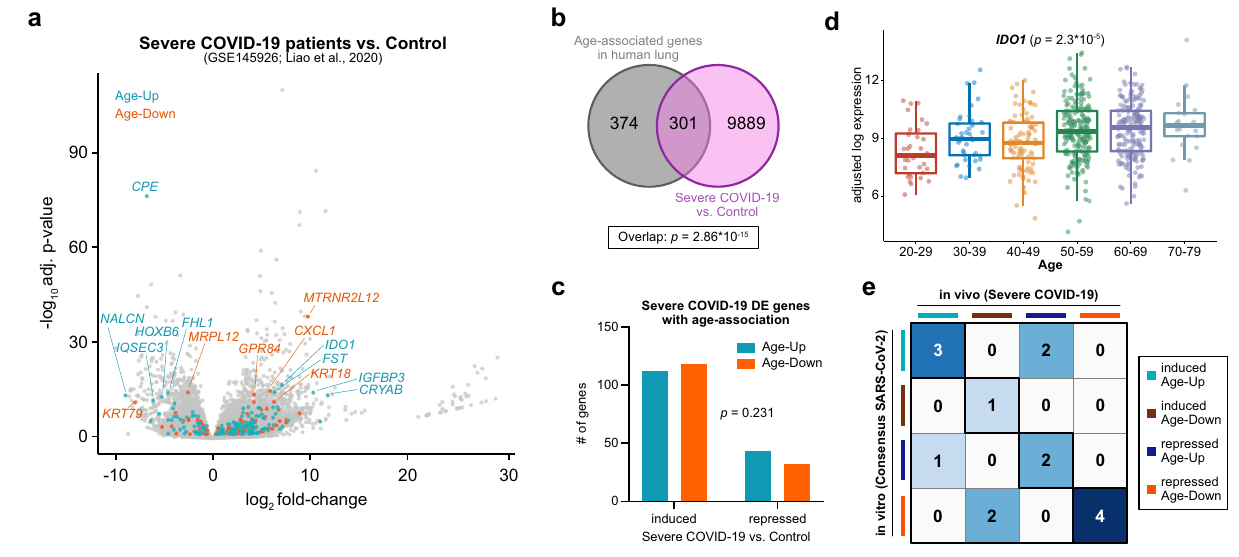
age) was not signi fi cantly associated ( Fig. 6c, Supplementary Data 28). Among the Age-Up genes that were upregulated in severe COVID-19 patients, IDO1 was the most signi fi cant (Fig. 6d). IDO1 encodes indoleamine-2,3-dioxygenase, a meta- bolic enzyme that has been demonstrated to have antiviral functions in a variety of contexts 79,80 .